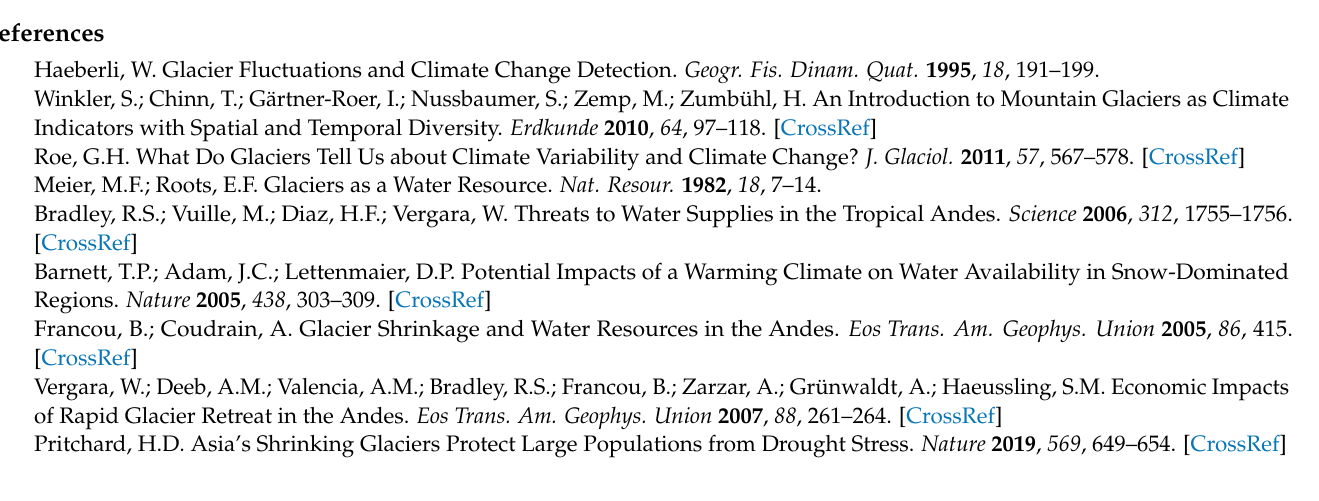
of North-Chuya ridge for